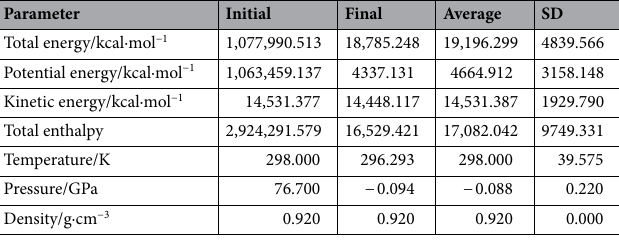
Table 2. The energy parameters of MD simulated structure.